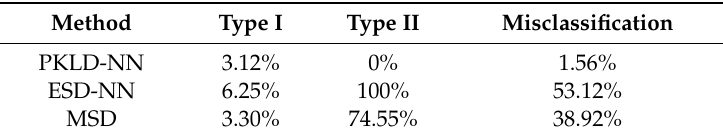
Table 2. Statistics of Type I and Type II errors, and misclassification rates by the PKLD-NN, ESD-NN and MSD